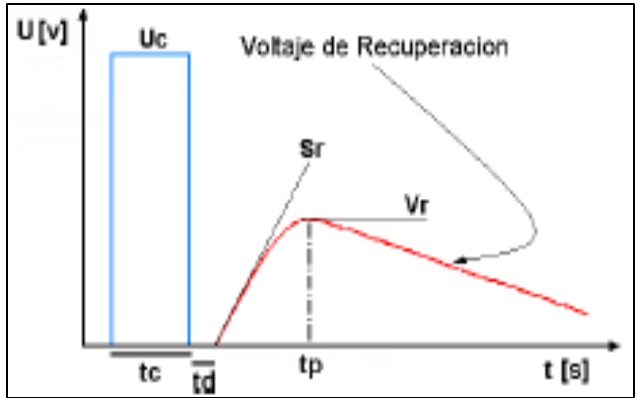
Figura 4: Voltaje de recuperación. Fuente: Autores,